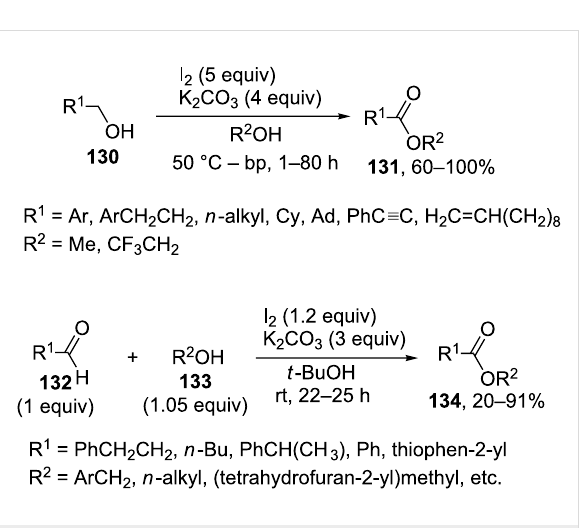
Scheme 26: Iodine mediated oxidative